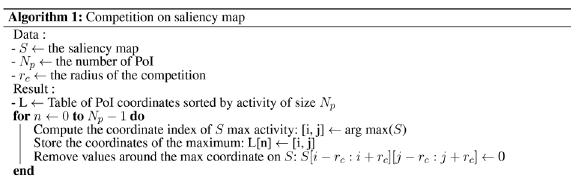
Algorithm 1. Competition on saliency map.